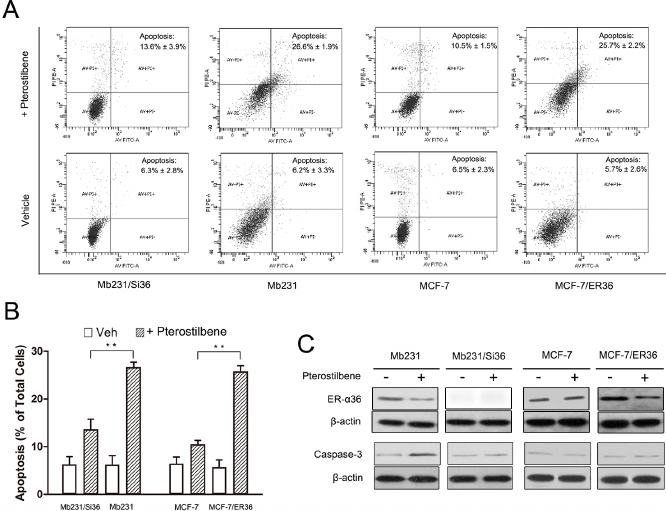
Figure 2. High ER- a 36 expression enhances pterostilbene-induced apoptosis in breast cancer cells. a . Apoptosis induction in Mb231, Mb231/Si36, MCF-7, and MCF-7/ER36 cells treated with 30 m M pterostilbene for 72 h was analyzed through flow cytometry (X-Axis: Annexin V; Y-Axis: Propidium iodide, PI). The apoptosis rates are presented as both early and late apoptotic cells compared to total cells. b . Statistical analysis of FACS in ( a ). c . Caspase-3 expression in the two paired cells after control and 30 m M pterostilbene treatment for 72 h. (Means 6 SE, ** p , 0.01).